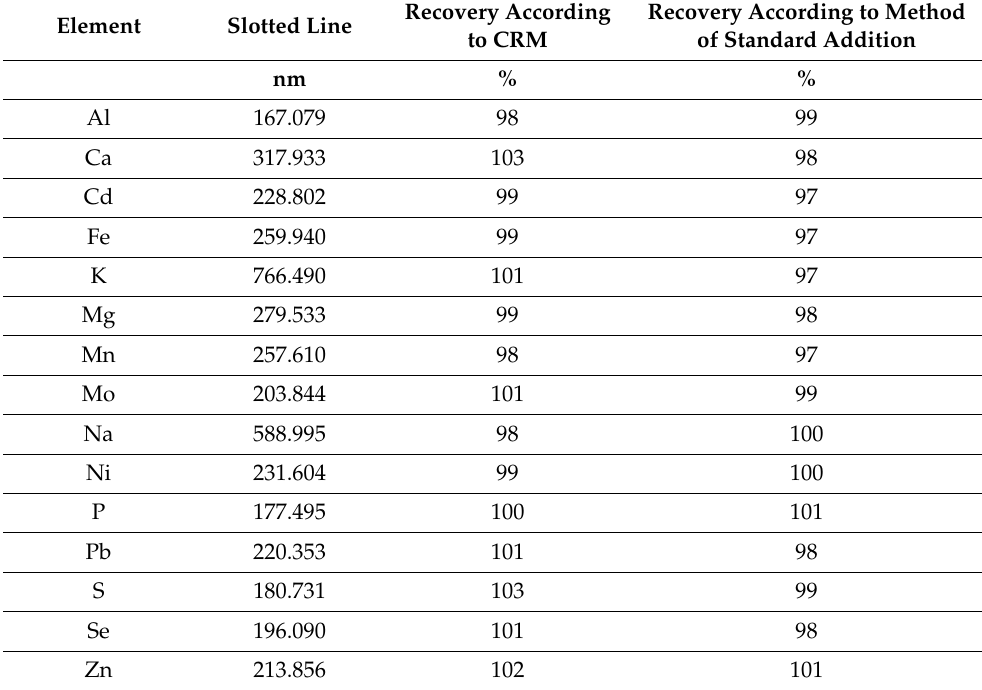
Table 1. The lengths of measurement lines and the recovery obtained for the specific elements